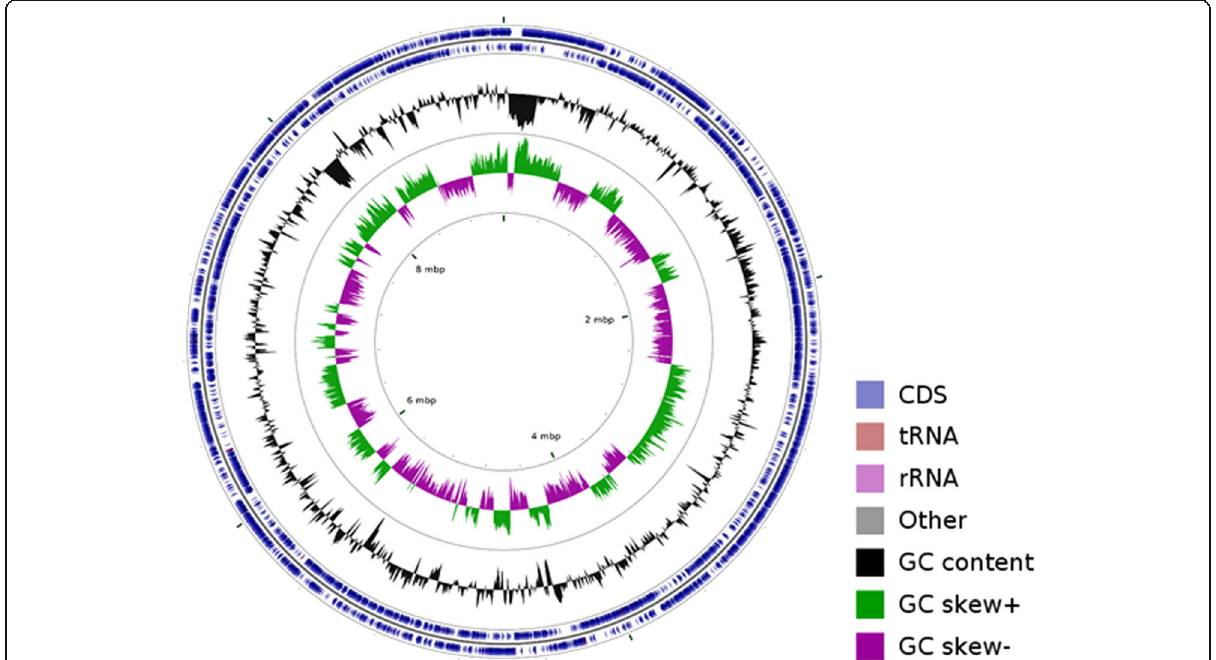
Fig. 4 A graphical circular map of strain P. ferrarius CY1 T . From outside to center, rings 1 and 2 denotes the predicted coding sequences on forward/reverse strand with each gene colored by its assigned COG category; ring 3 shows G + C % content plot and ring 4 shows GC skew